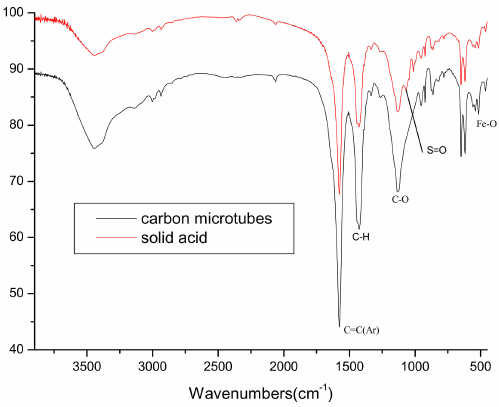
Figure 1. The IR spectra of magnetic carbon microtubes and solid acid.